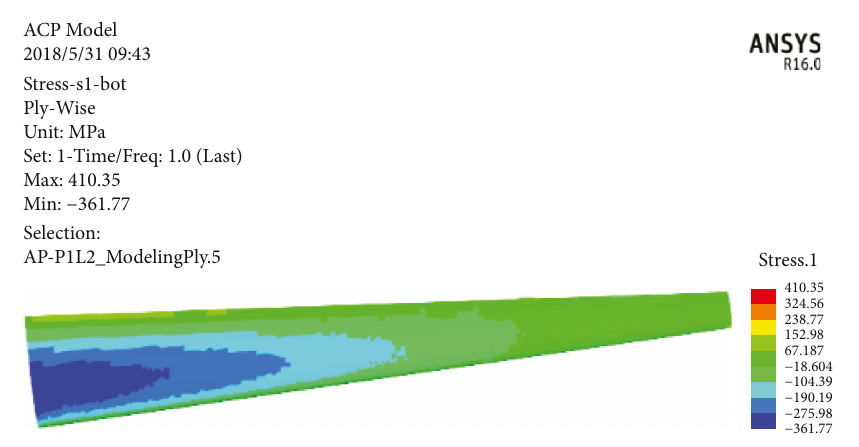
Figure 54: Stress cloud diagram of the upper wing with the layer ratio being 70%/20%/10%.